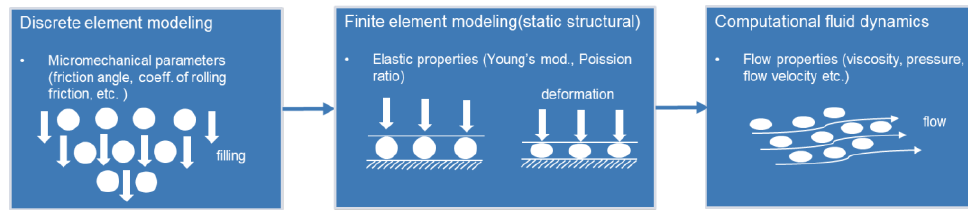
Figure 7. The flow chart of the method.